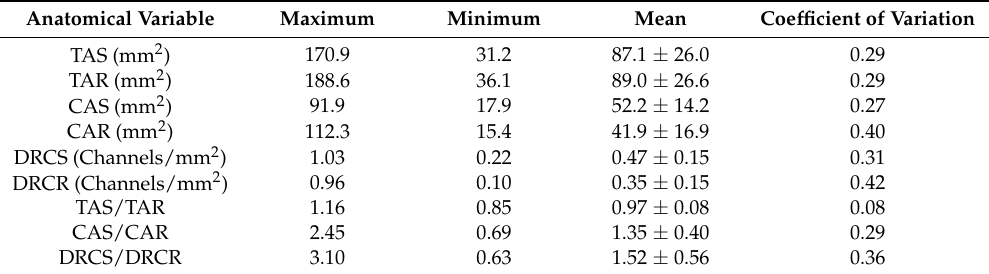
Table 3. Results of the measurements of the anatomical variables of scions and rootstocks.